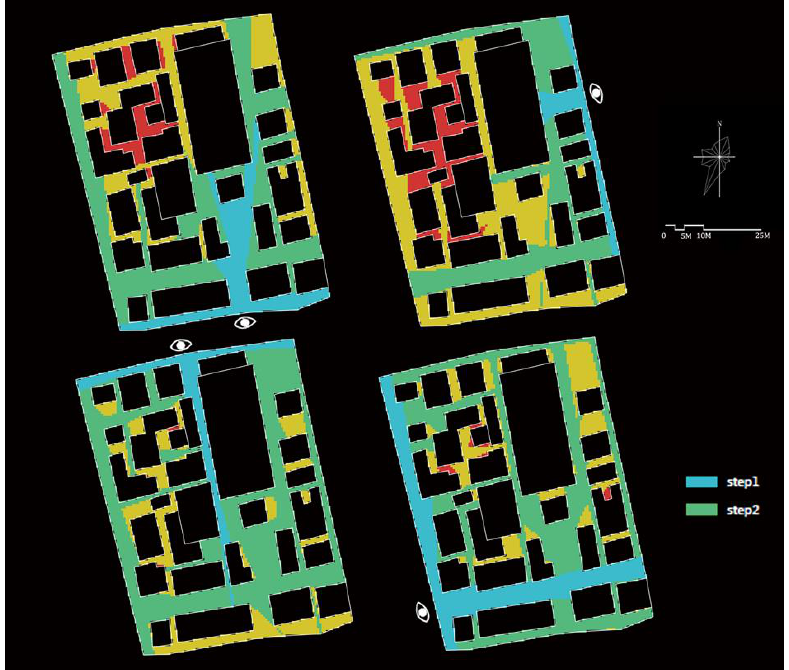
Figure 6. Visibility Graph Analysis of the highlighted block in Figure 5 (The step1 denotes the most likely selected space for a tourist at the location of the eye symbol and step2 denotes the most likely selected space for tourist after step1.)